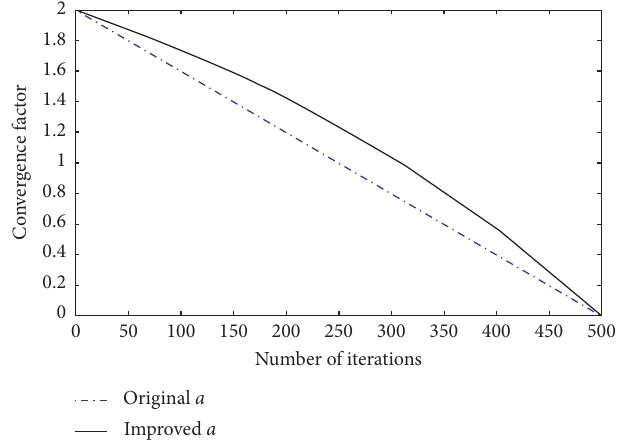
Figure 3: The change of the convergence